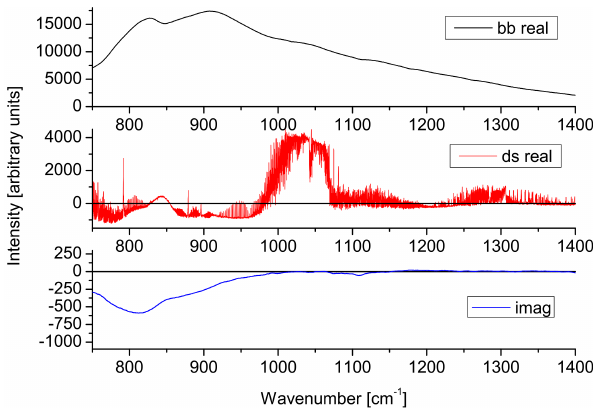
Figure 11. Raw spectra showing the real part of a blackbody spec- trum (top), the real part of a deep space spectrum (middle) and the imaginary part of a deep space spectrum, which represents the beam-splitter emission (bottom).